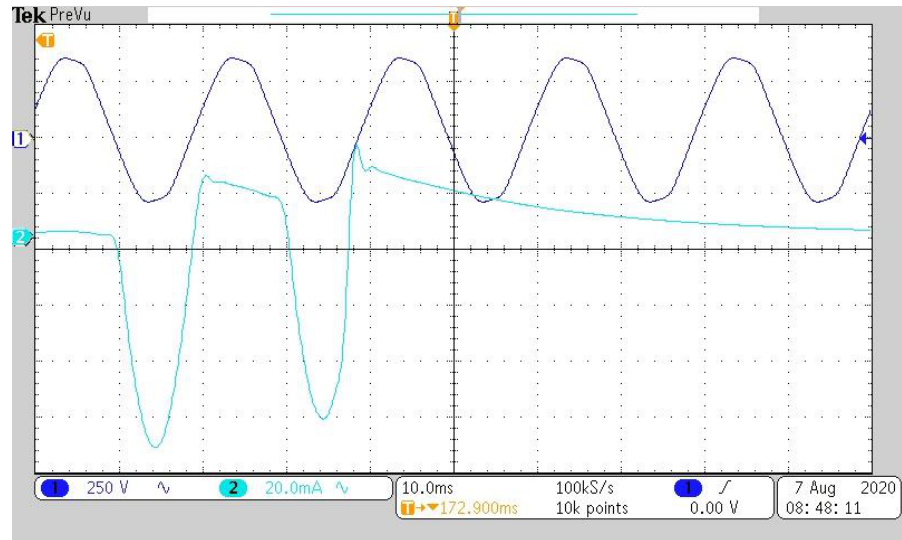
Figure 12. Supply voltage (channel 1) and tripping current (channel 2) vs. time for RCD-2 (Table 4) and the input one-half sinusoidal with negative polarity.